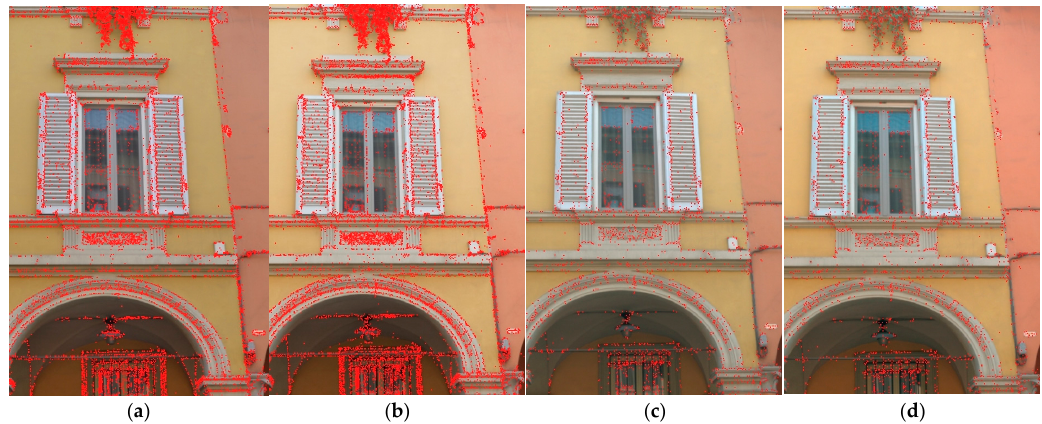
Figure 9. Results of SIFT interest point detection using different color enhancements: ( a ) no enhancement; ( b ) manually enhanced; ( c ) automatically enhanced; ( d ) automatically enhanced using the whole pipeline (polynomial regression + ACR based correction). Although in ( d ) the number of detected points is lower, they are more robust and reliable, allowing better orientation procedures.